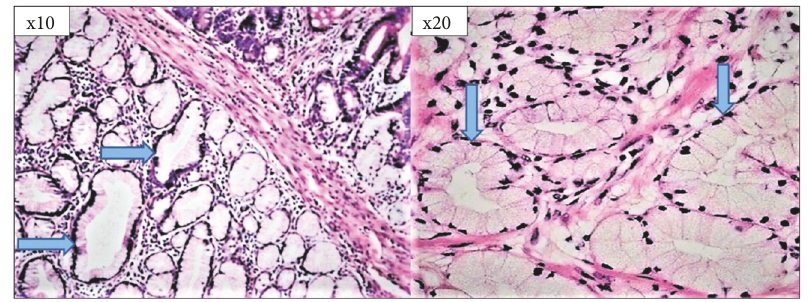
Figure 2: Brunner’s gland hamartoma in the duodenal bulb (H–E; × 10 and ×